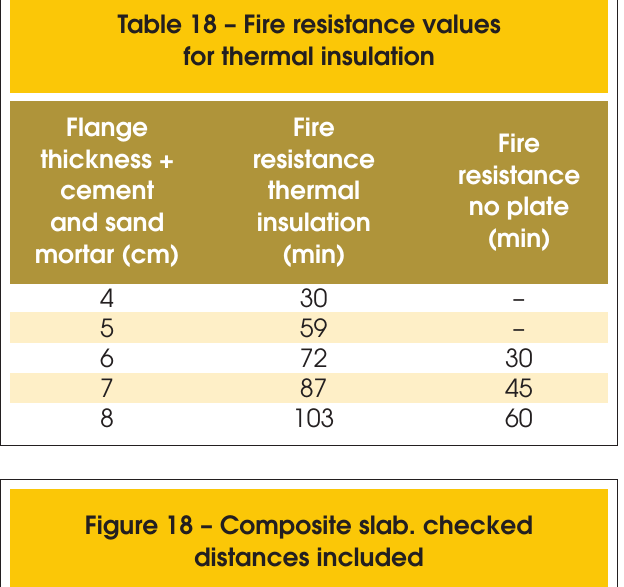
Figure 18 – Composite slab. checked distances included